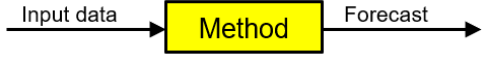
Figure 13. General structure of single method.